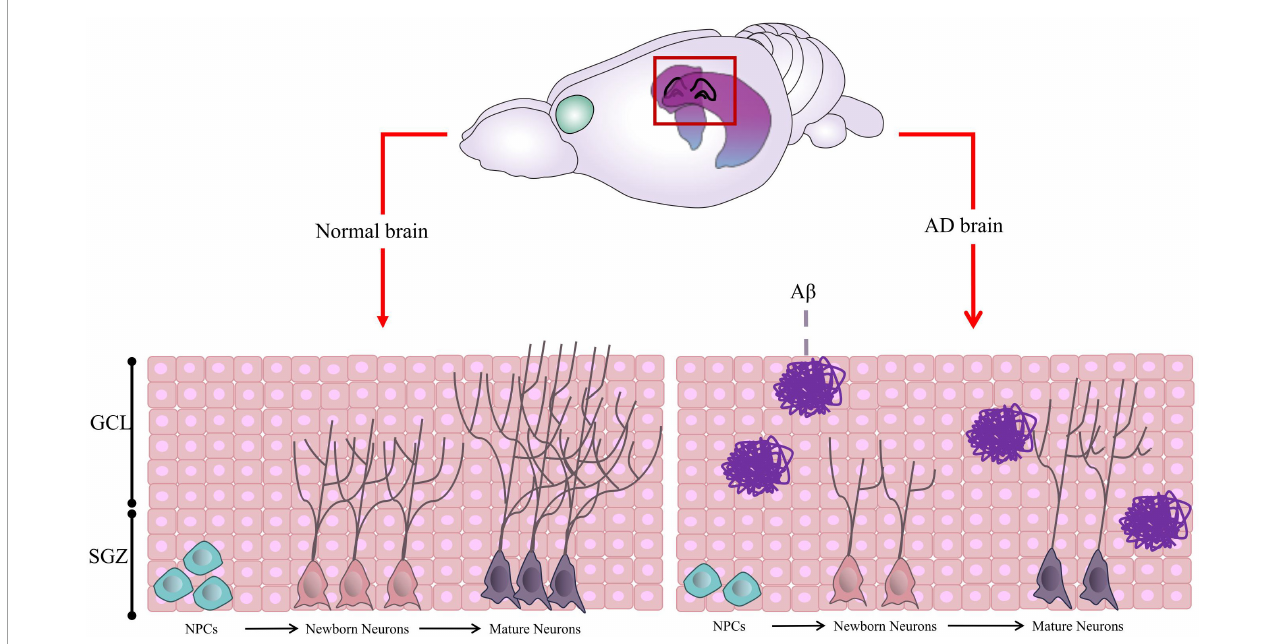
FIGURE1 Graphic illustration of Adult Hippocampal Neurogenesis (AHN). In normal brain, the neural precursor cells (NPCs) located in the Subgranular Zone (SGZ) proliferate and differentiate to form neural progenitor cells or neuroblasts, which further differentiate into new neurons. The newborn neurons continue to migrate, proliferate, develop axons and dendrites, become mature neurons, and integrate into the hippocampal network. However, in AD brain, the proliferation and differentiation of neurons are inhibited due to A β aggregation and other factors in most cases. Some of this illustration was started from a Scidraw Template.